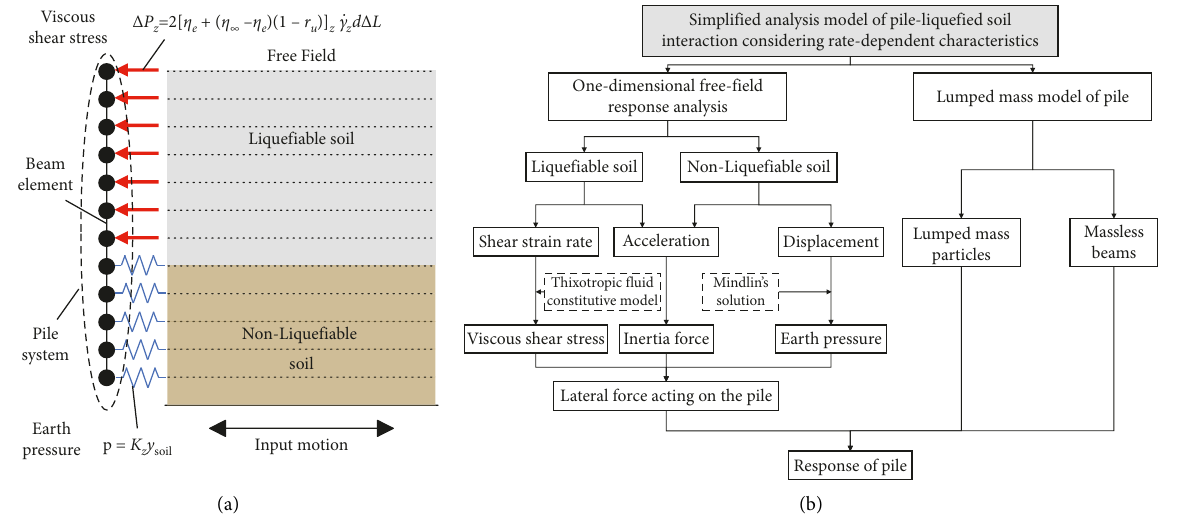
Figure 2: Analytical scheme for the simplified analytical method considering rate-dependent characteristics: (a) schematic diagram of the pseudo-static method; (b) chart for the model